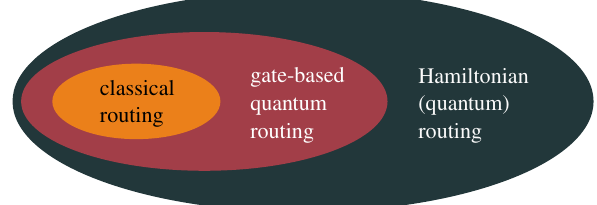
FIG. 1. The relative power of routing models considered in this work. Most prior work considers only using SWAP gates for routing, which we call classical routing . In this work, we explore the additional routing power provided by genuine quantum oper- ations. We consider increasingly more powerful quantum routing models: first, allowing arbitrary two-qubit gates in gate-based quantum routing , and then allowing continuous Hamiltonian evolution in Hamiltonian (quantum) routing